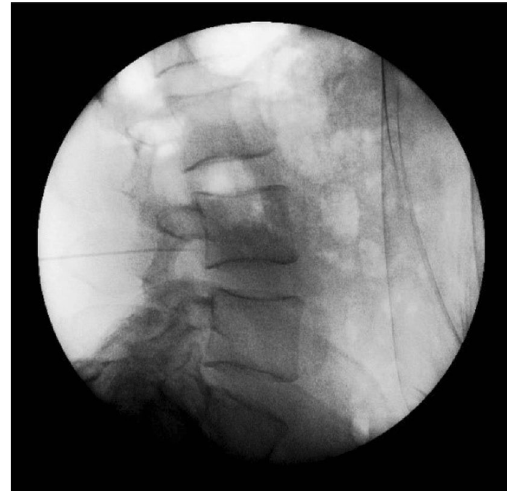
Figure 2. Fluoroscope verification of needle placement at L4/L5 in lateral view.